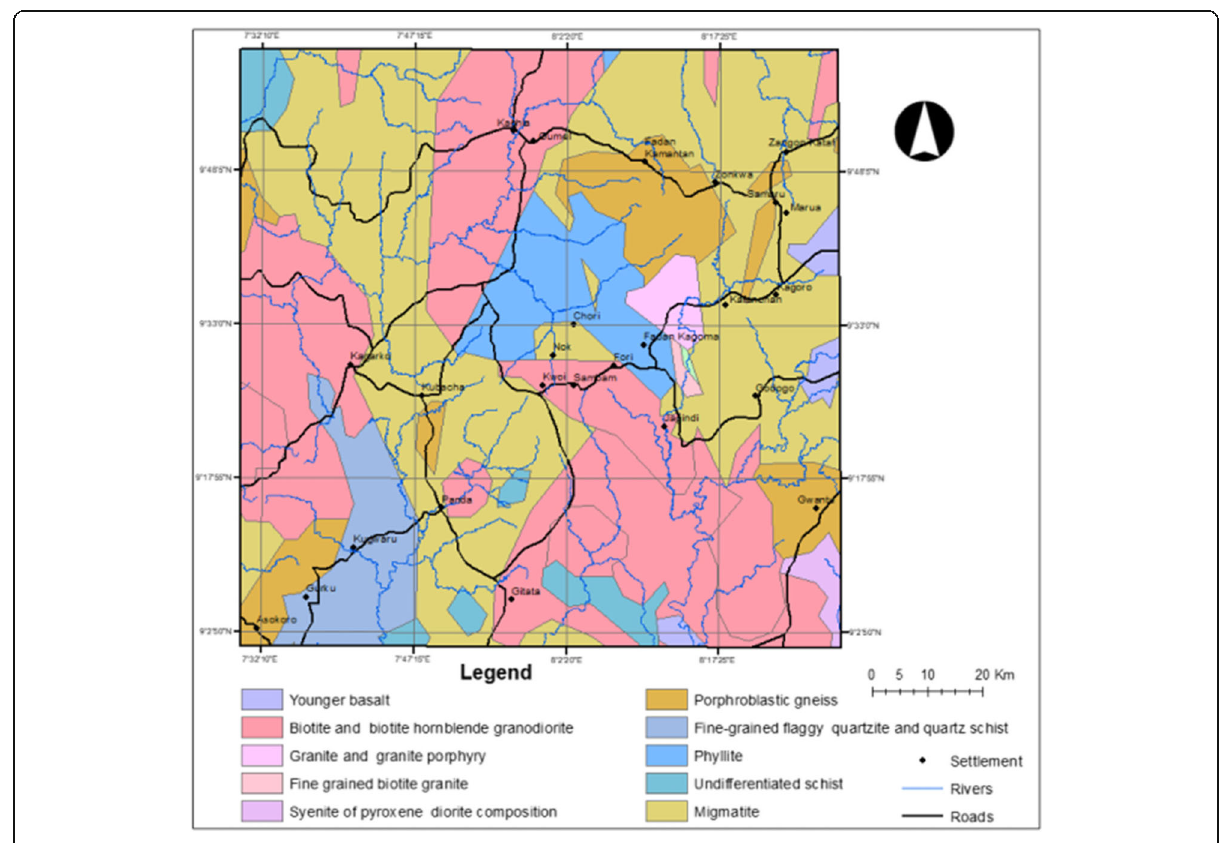
Fig. 3 Geological map of the Kwoi area (source: GSN 2004)